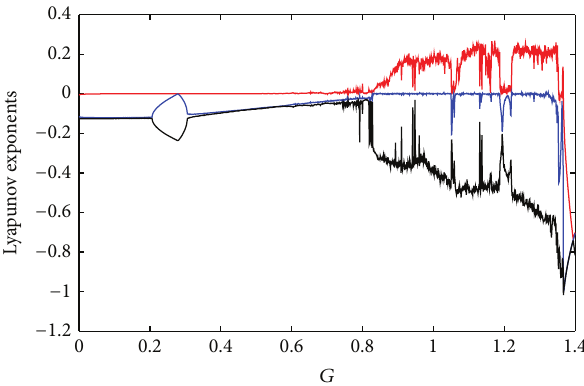
Figure 4: Lyapunov exponents about 𝐺 for the parameter 𝐹 = 8 . and the four vertices of 𝐷 2